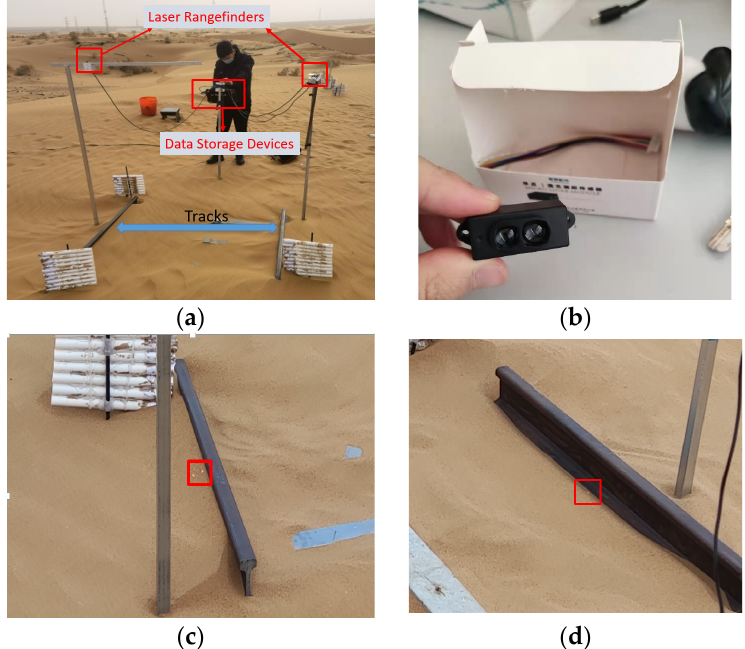
Figure 5. Scene of field experiment based on laser ranging. ( a ) field experiment; ( b ) laser rangefinders; ( c ) measurement point for the first track; ( d ) measurement point for the second track.